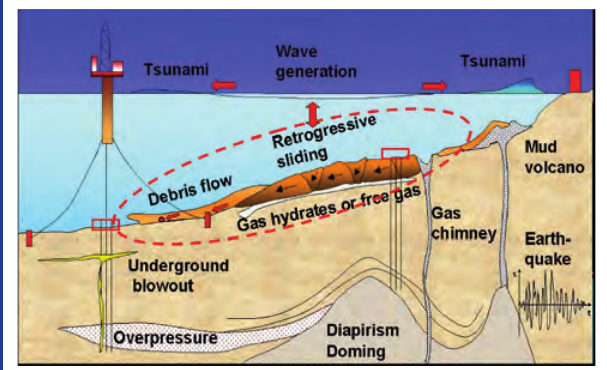
Figure 4. Summary of slope processes that may contribute to failure, generating landslides, debris flows, and tsunami (from Camerlenghi et al., (2007), courtesy Norwegian Geotechnical Institute (NGI) and the International Centre for Geohazards